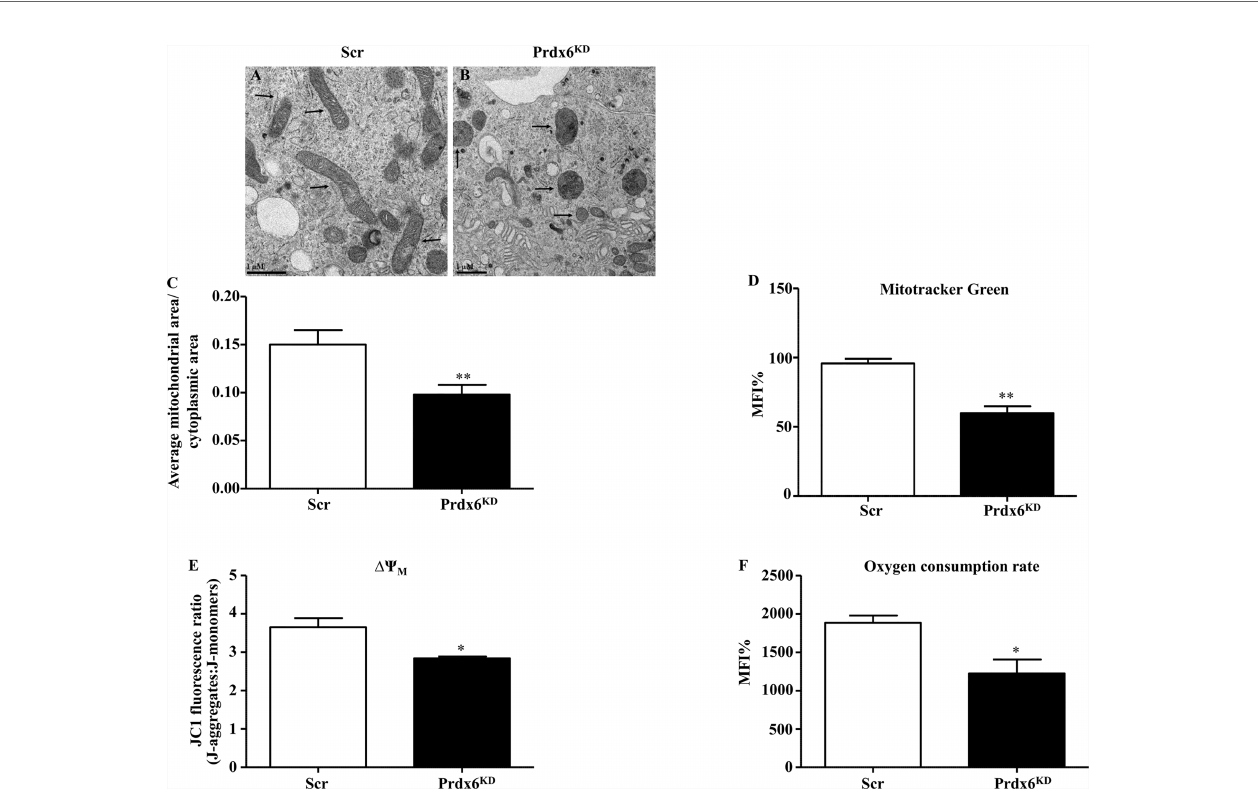
FIGURE 3 | Ultrastructural and functional changes of mitochondria in b -cell knockdown for Prdx6. (A, B) Transmission electron images of Scr and Prdx6 KD . Original magni fi cation ×20,000. (C) The ratio between mitochondrial and cytoplasmic areas was also evaluated in both Prdx6 KD and Scr cell lines. (D) Mitochondrial mass was assessed by cyto fl uorimetric analysis using MitoTracker Green in both Prdx6 KD (black- fi lled bar) and Scr (white- fi lled bar) cell lines. (E, F) Mitochondrial functional state was evaluated in Prdx6 KD (black- fi lled bar) and Scr (white- fi lled bar) cell lines by measuring the membrane potential ( DY m) and oxygen consumption rate. Values are expressed as mean ± SEM. *p < 0.05, **p < 0.01 (n = 5). a.u., arbitrary units; MFI: mean fl uorescence